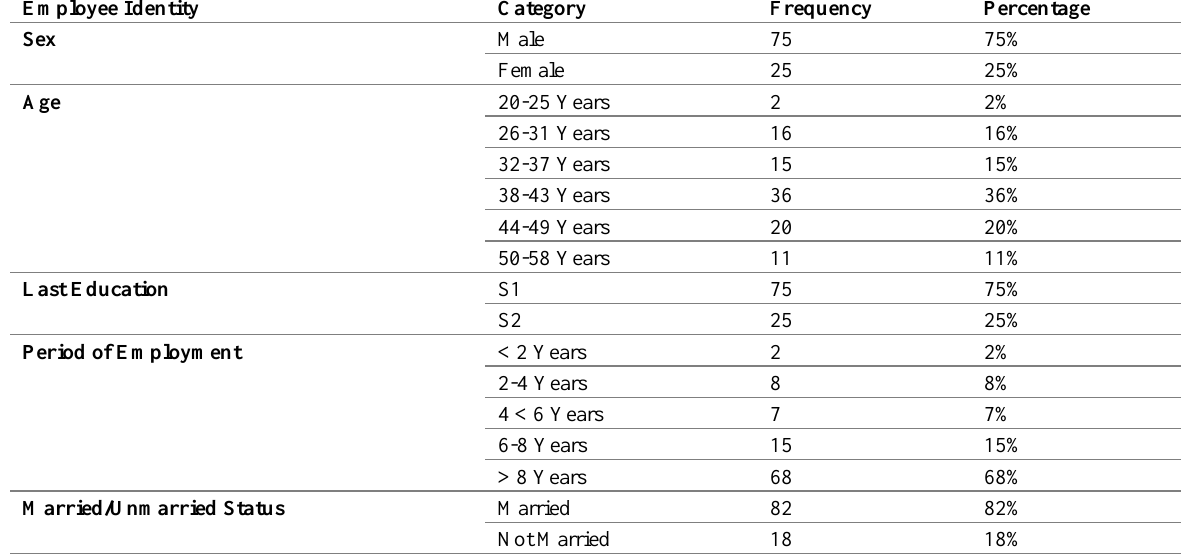
Table 2: Characteristics of civil servants